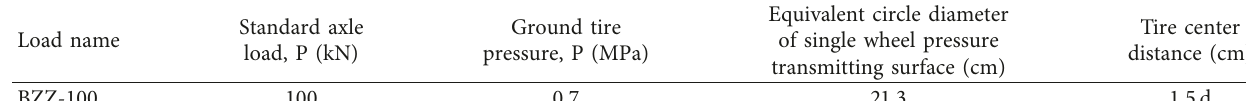
Table 2: Design parameters of standard axle load.